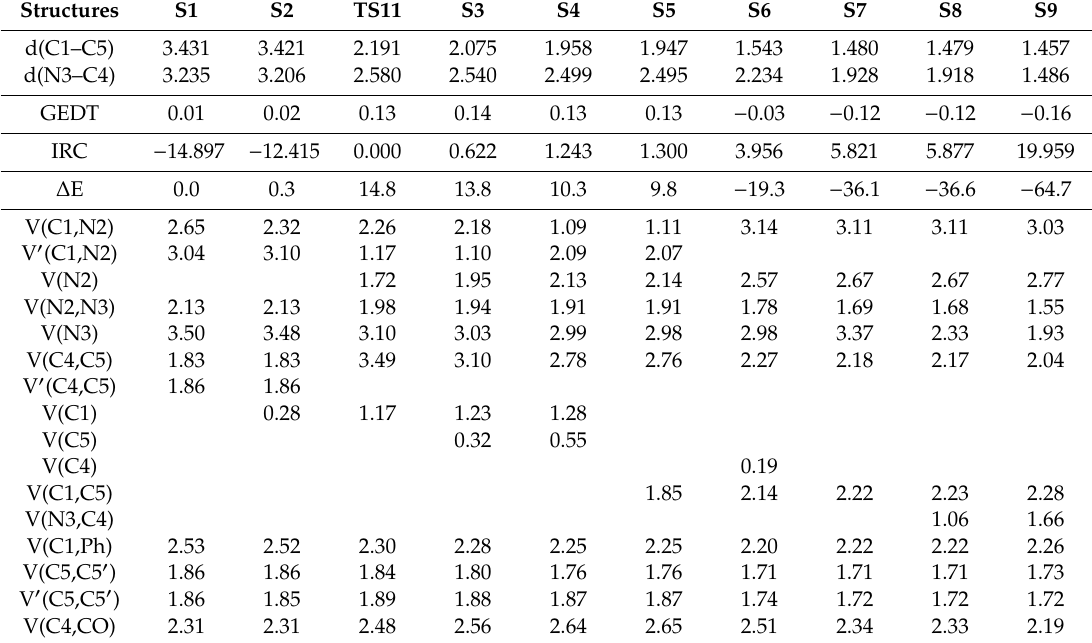
Table 2. Electron populations of the most relevant electron localisation function (ELF) valence basins, relative a energies, intrinsic reaction coordinate (IRC) values, global electron density transfer (GEDT) and distances of the forming bonds, for selected structures, S1 – S9 , involved in the formation of the C1–C5 and N3–C4 single bonds along the IRC of the 32CA reaction between NI 1 and allenoate 4 . Populations and GEDT are given in average number of electrons, e, relative energies in kcal · mol − 1 and distances in angstroms,